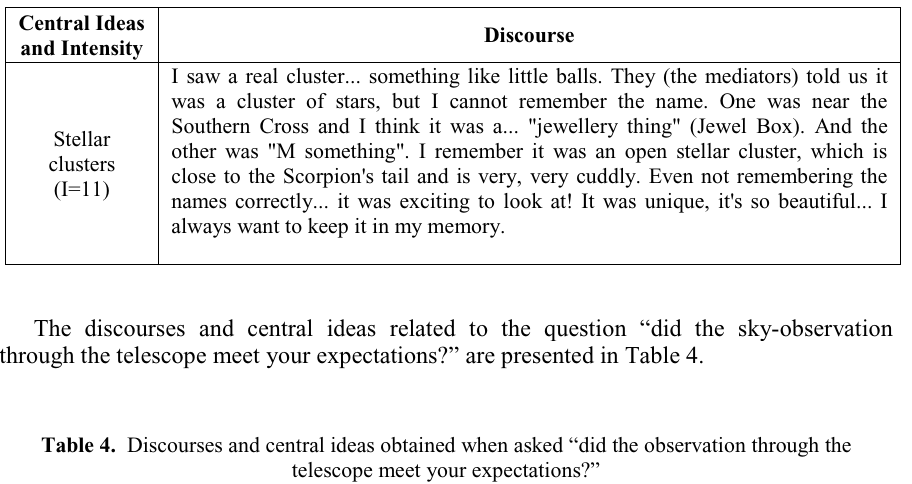
Table 2. Discourses and central ideas obtained when asked “was the talk 'The Sky of the Month' Central Ideas and Intensity